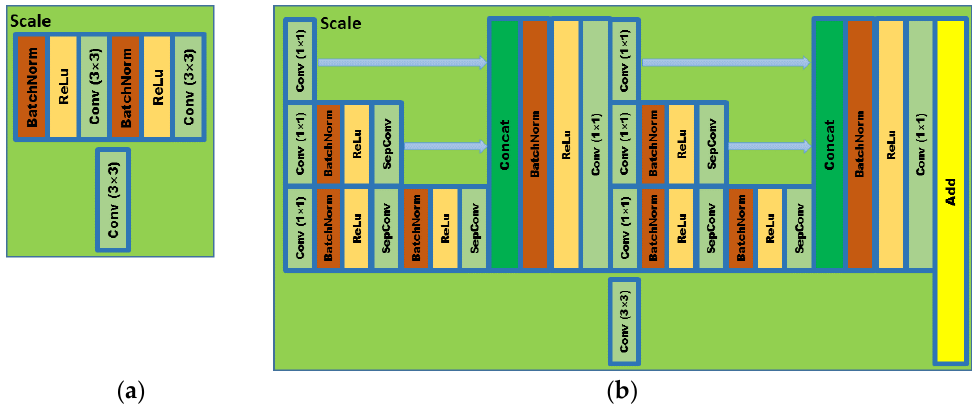
Figure 8. The original and improved structure of the Scale